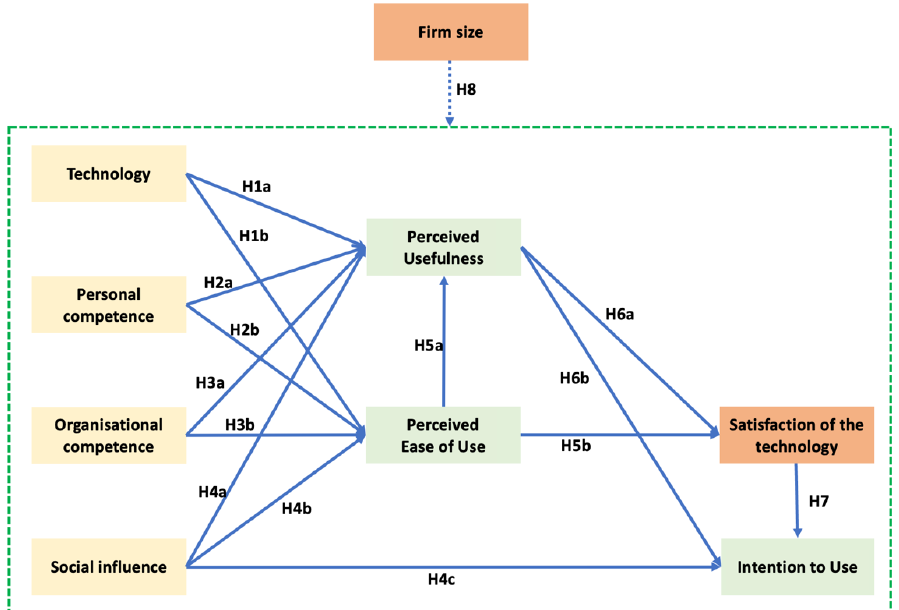
Figure 2. Research